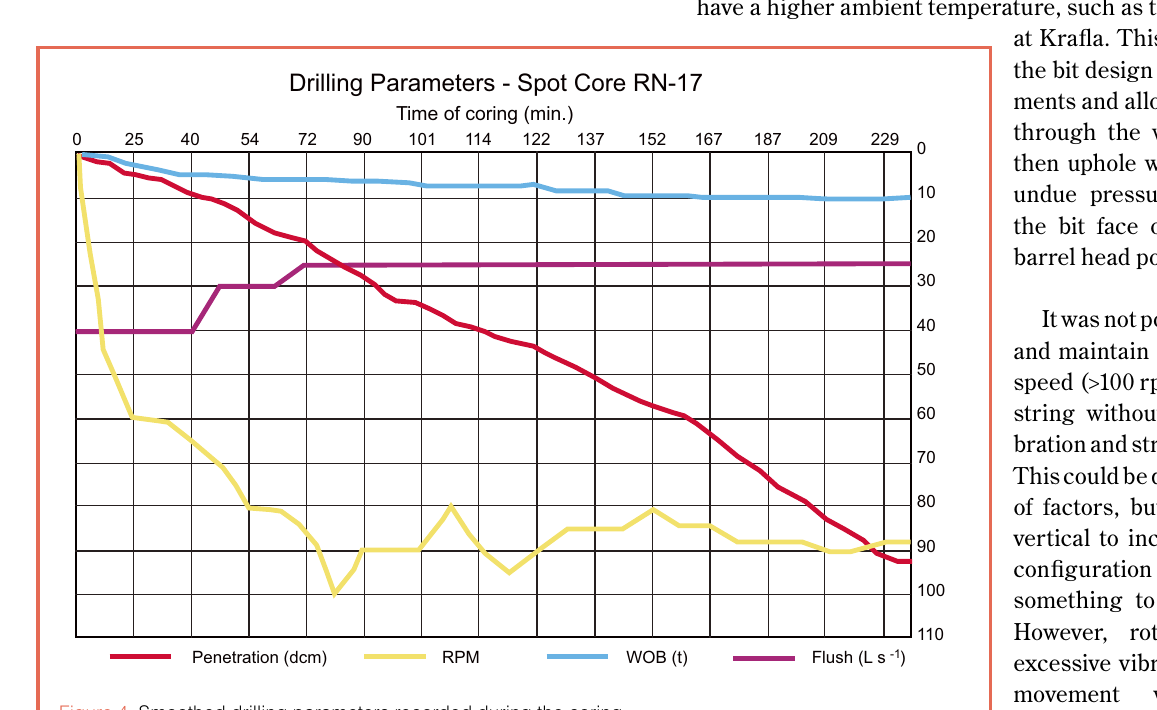
Figure 4. Smoothed drilling parameters recorded during the